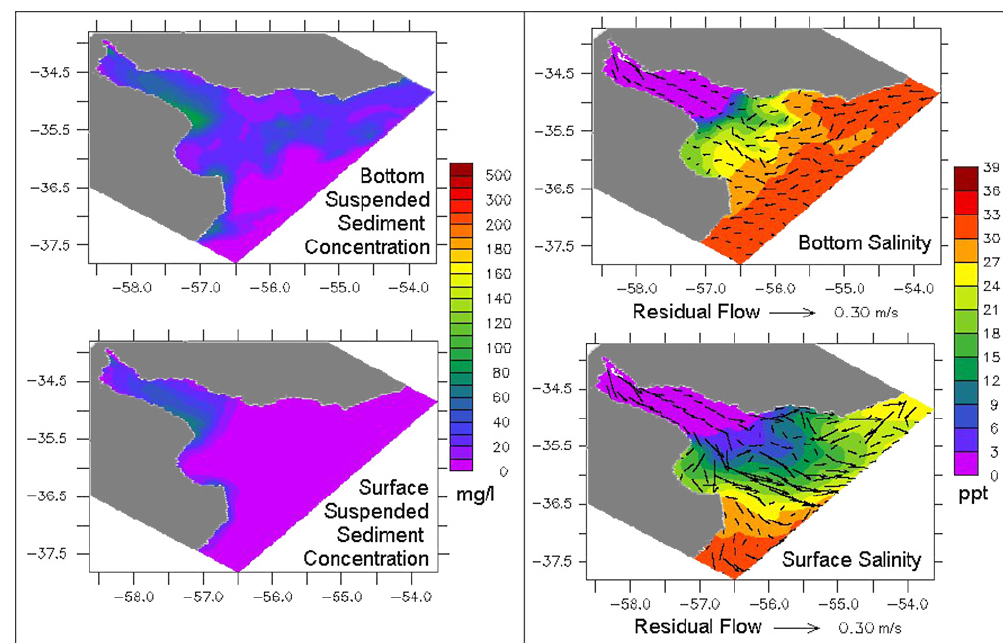
Fig. 4. Mean computed fields obtained over the 17–23 August 2010 period (fair weather conditions): bottom suspended sediment concen- tration (upper left panel), surface suspended sediment concentration (lower left panel), bottom salinity and residual flow (upper right panel), surface salinity and residual flow (lower right panel).